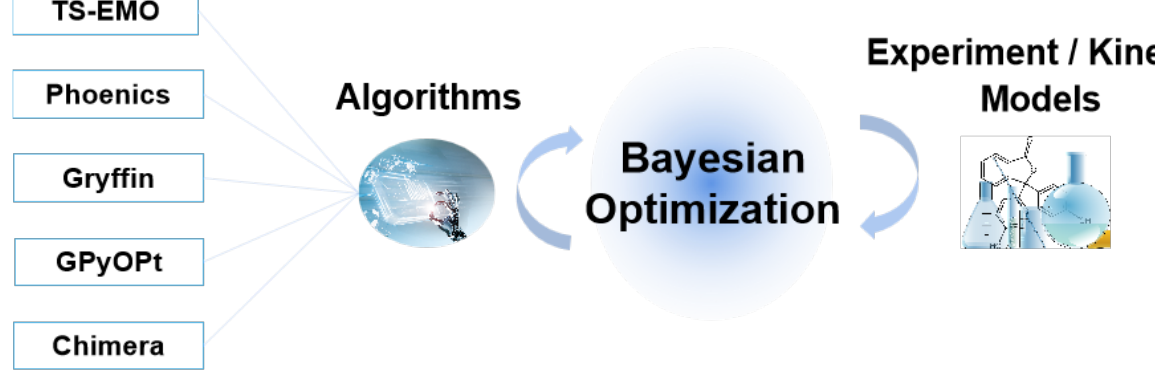
Figure 9. The Bayesian optimization algorithms with a self-optimizing platform.